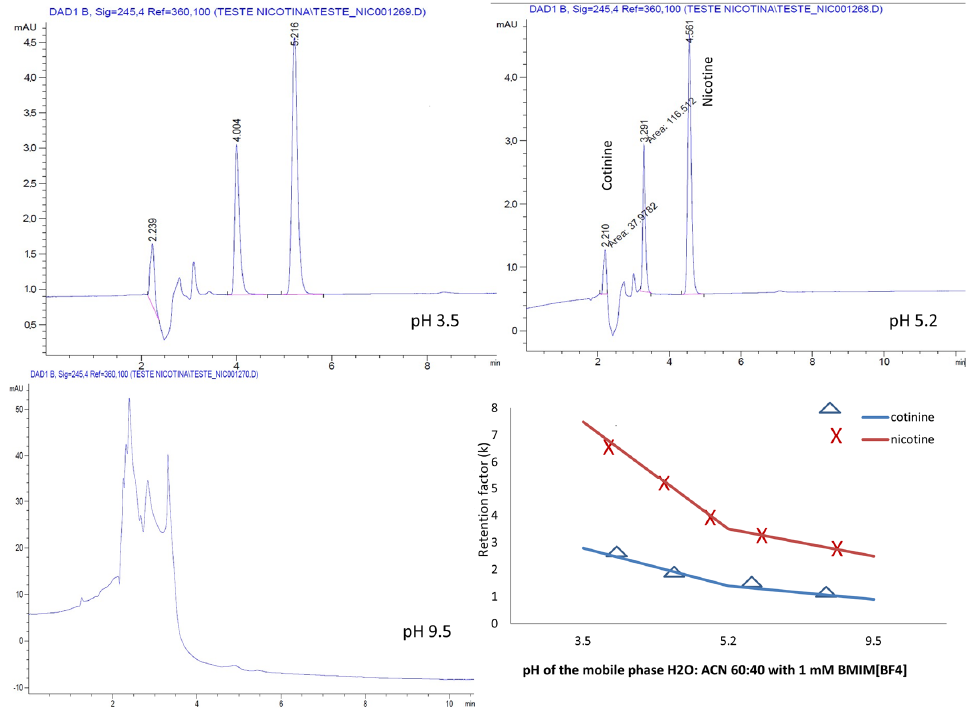
Figure 7. Chromatograms and variation in the pH-dependent retention factor for nicotine and cotinine with mobile phases containing H 2 O:ACN 60:40 and 1 mM BMIM[BF 4 ].